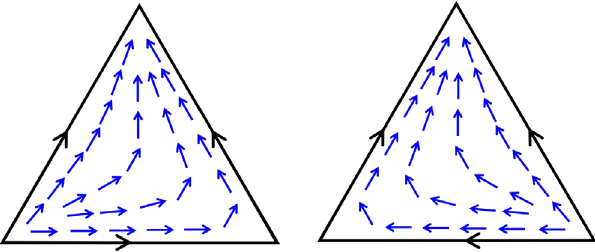
1 and o − 1 triangles. pqr ¼ þ pqr ¼